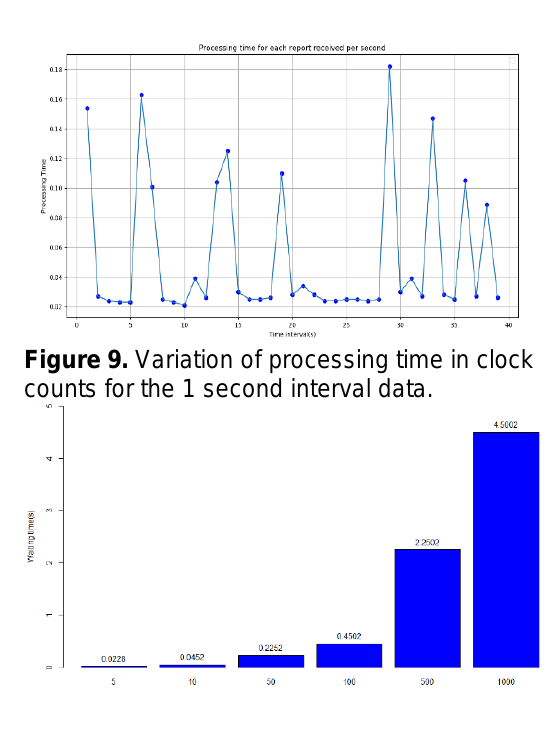
Figure 10 . Average waiting time for different transmission